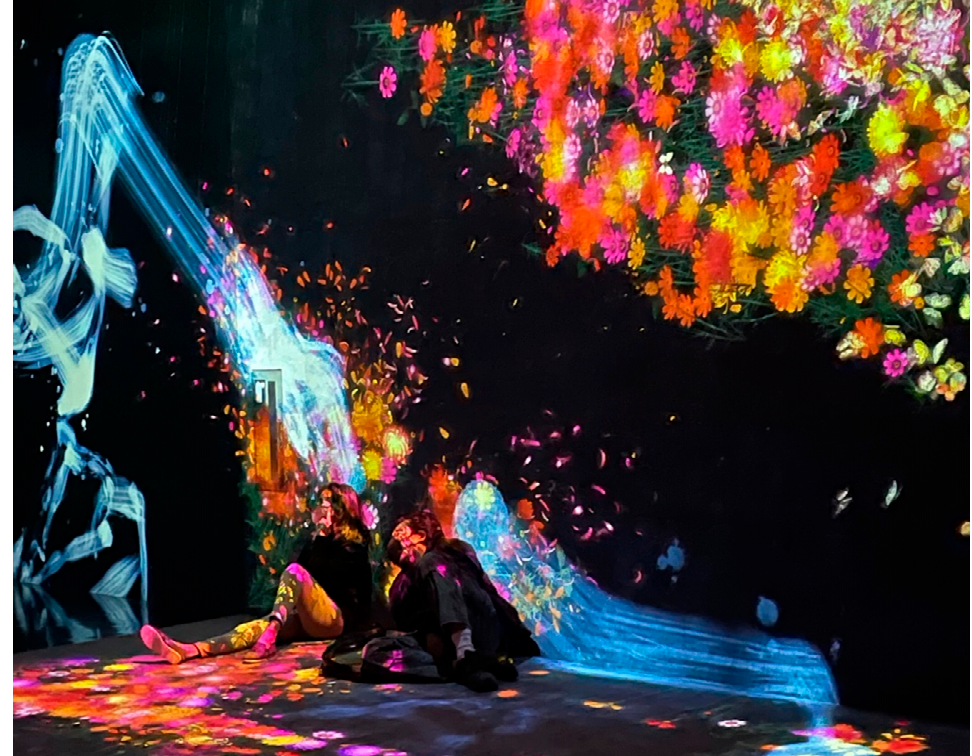
Figure 12. teamLab, Forest of Flowers and People: Lost, Immersed and Reborn (slow down), 2017/2021, Asian Art Museum of San Francisco; photograph by the author, 2022.